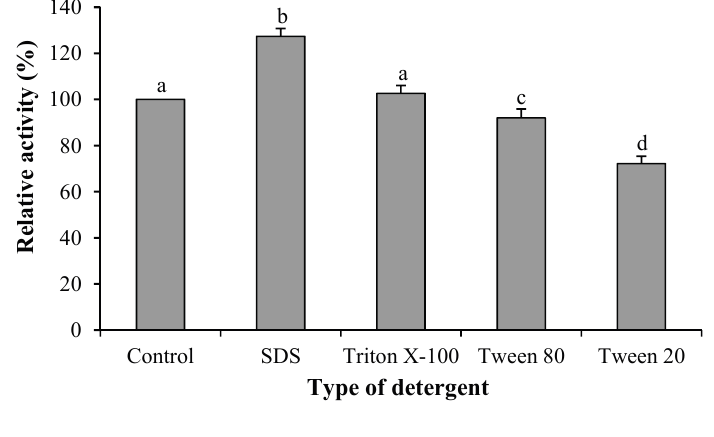
Figure 6. Effect of detergents on activity of ginger protease. Different superscripts indicate a significant difference ( p ≤